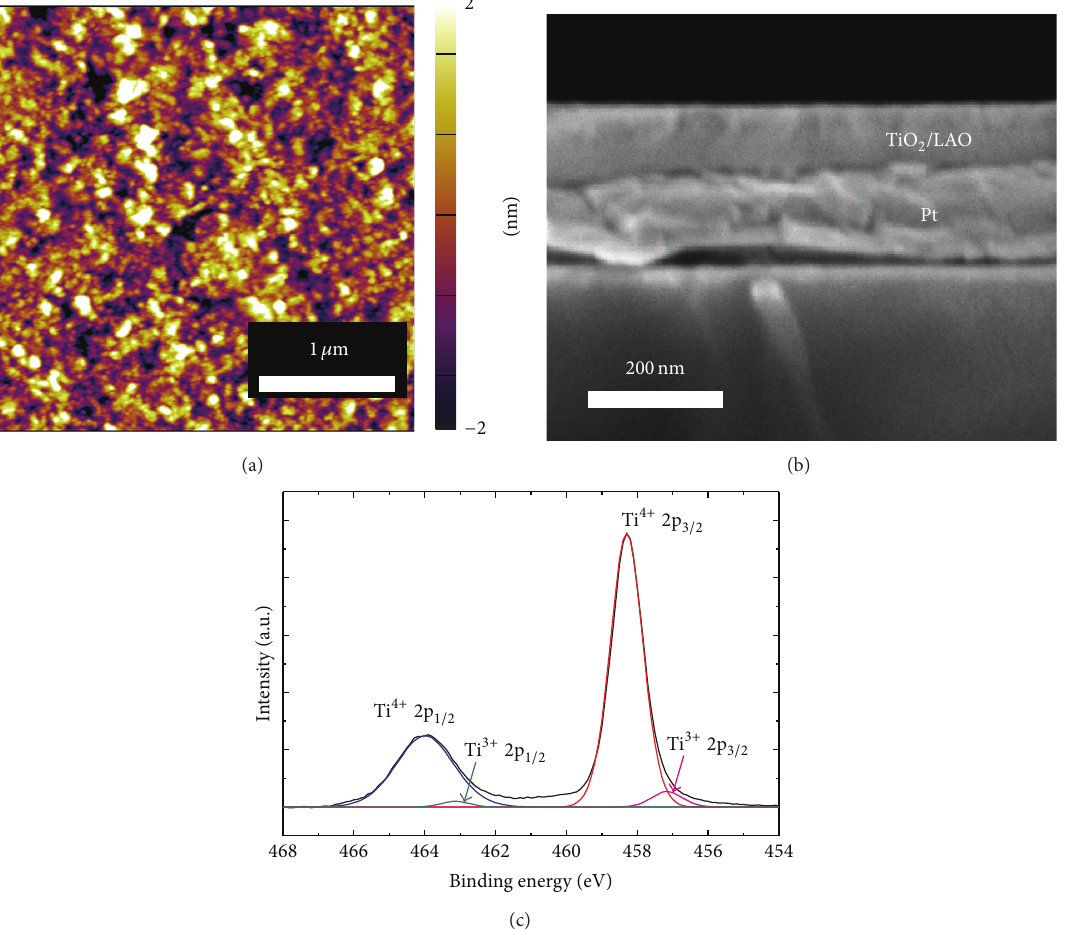
Figure 1: (a) Surface morphology, (b) cross-sectional SEM image, and (c) XPS spectra of the Ti 2p core-level electrons.